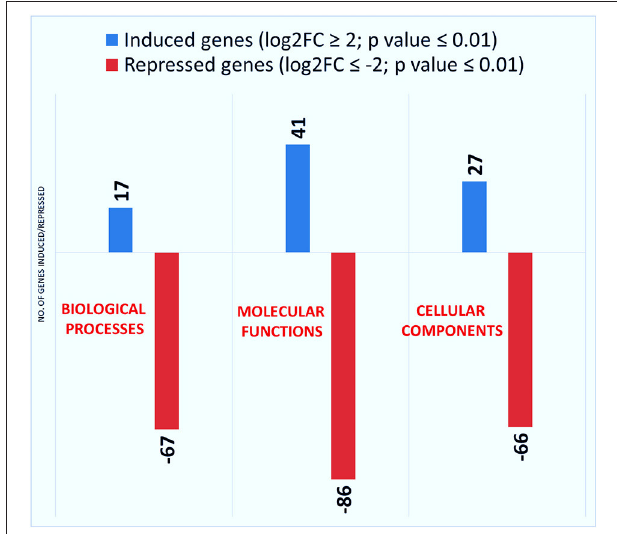
FIGURE 5 | Mapman diagrams representing up- and downregulated genes due to KSWE application at V5 stage under drought. (A) Metabolism overview. (B) Regulation overview. Fold changes are indicated by the color scale (red and green represent up- and downregulated genes, respectively).